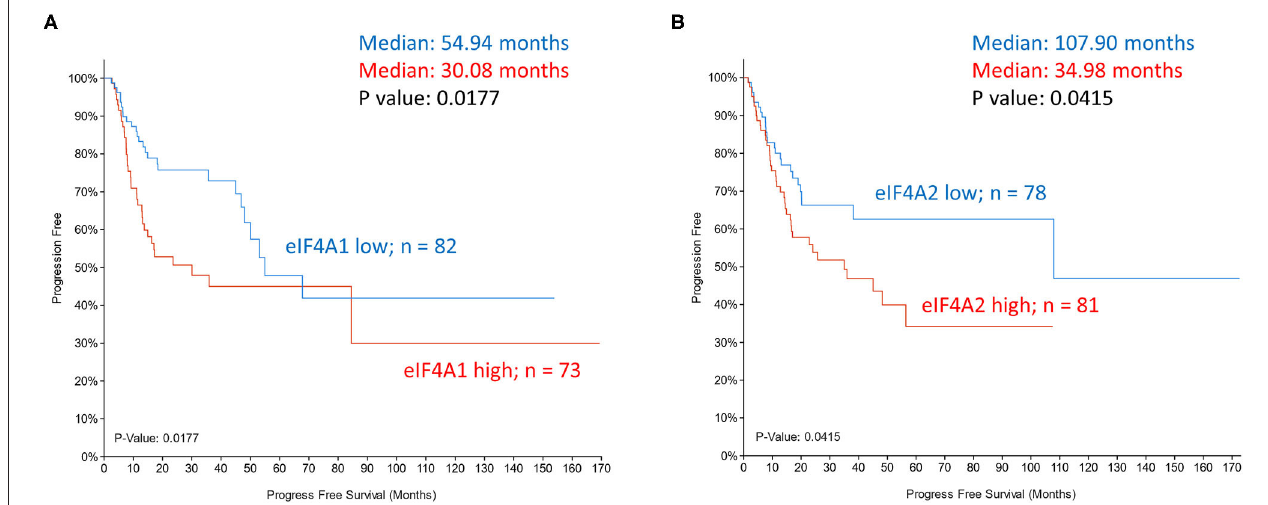
FIGURE 5 | Kaplan-Meier plots of progression-free survival of head and neck cancer patients (TCGA dataset) grouped based on mRNA expression z-scores relative to all samples (log RNA Seq V2 RSEM). (A) eIF4A1 expression z scores > 1 (samples 73; red ) and z score < -1 (samples 82; blue ). (B) eIF4A2 expression z scores > 1 (samples 81; red ) and z score < -1 (samples 78; blue ). P -values are